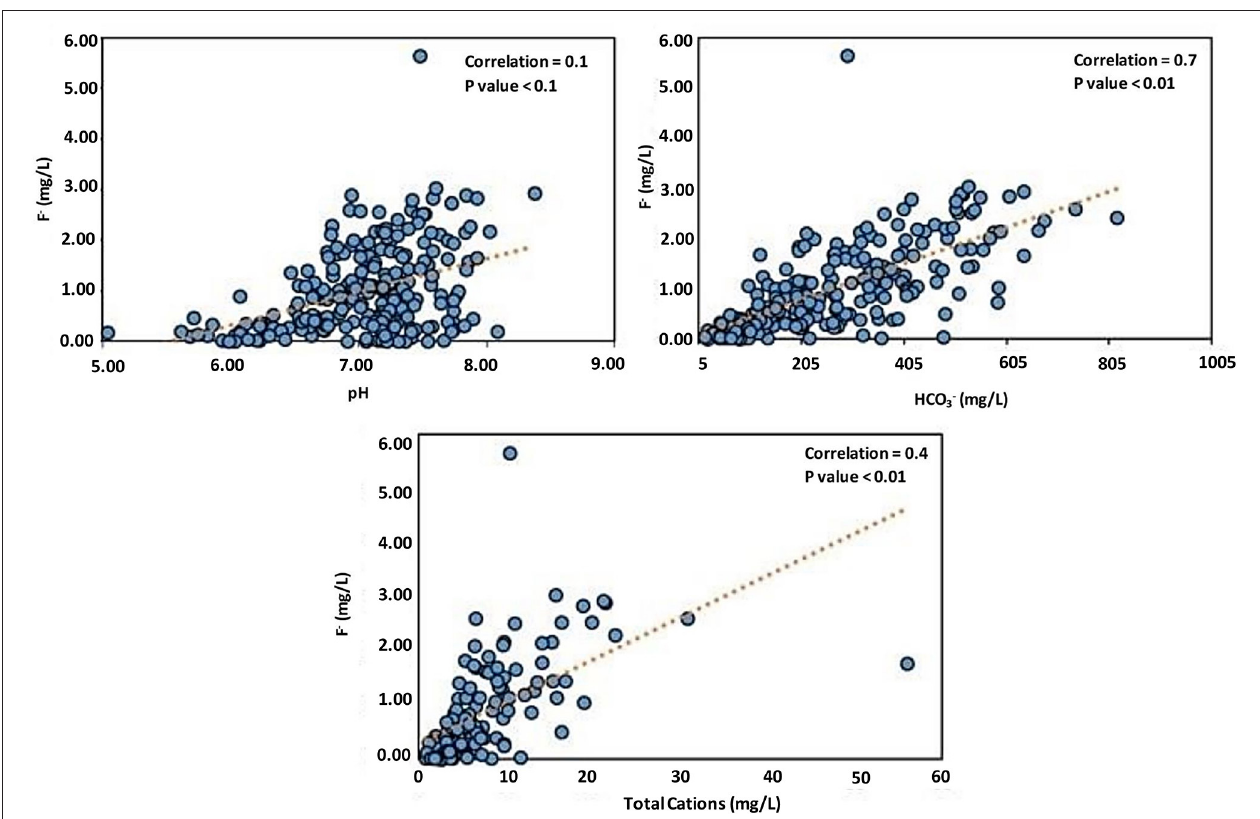
FIGURE 4 | The correlation of F − with pH, HCO − 3 , and total